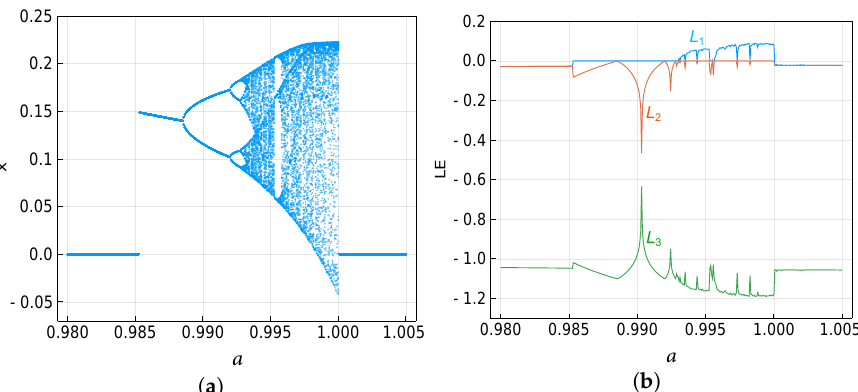
Figure 7. ( a ) Bifurcation diagram, and ( b ) Lyapunov exponents spectrum versus a of system (27).